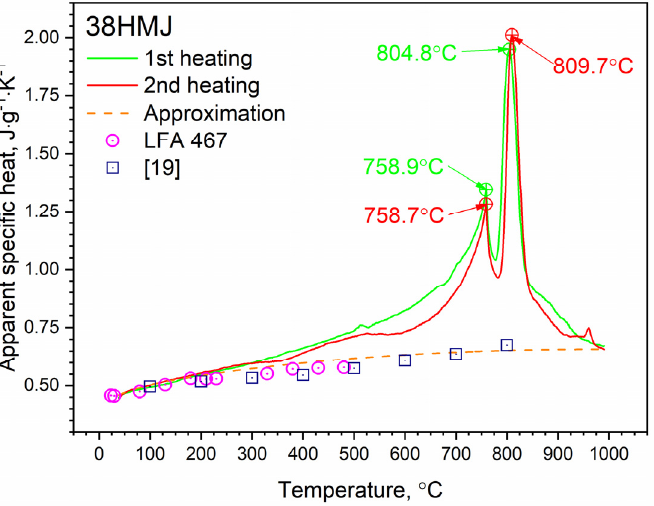
Figure 4. Temperature characteristics of apparent specific heat for 38HMJ steel (own research results vs. literature data).